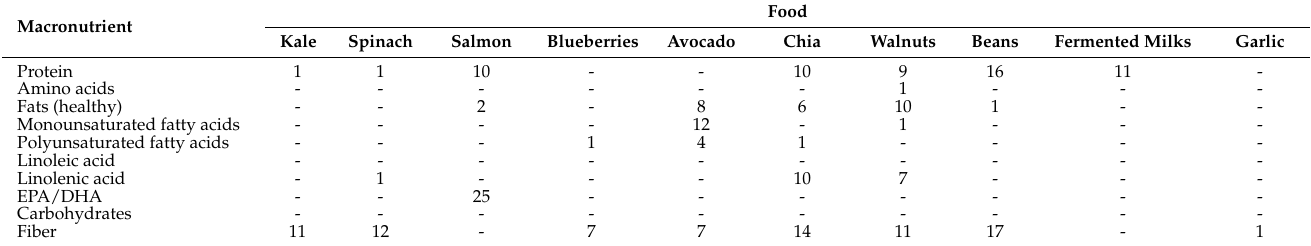
Table 10. Macronutrients of ‘superfoods’ and number of selected websites that mentioned each one.